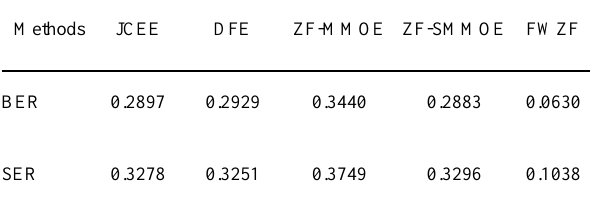
Table 2. Comparative discussion using the ZF methods in Rayleigh Methods